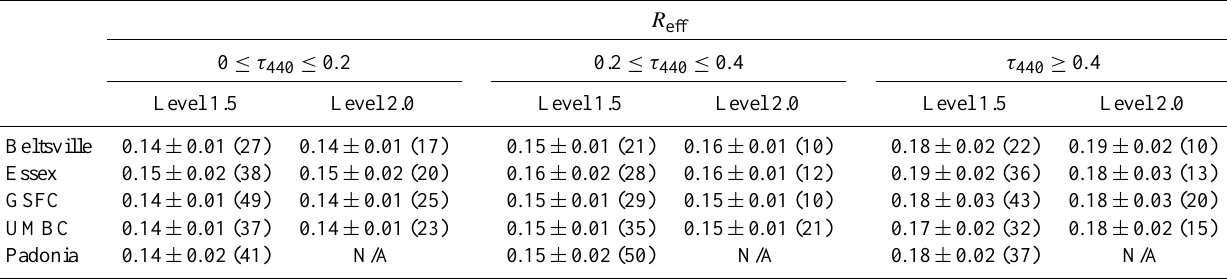
Table 3. July mean values of effective radius R eff for different aerosol loadings and different quality levels for all AERONET/DRAGON stations considered in this